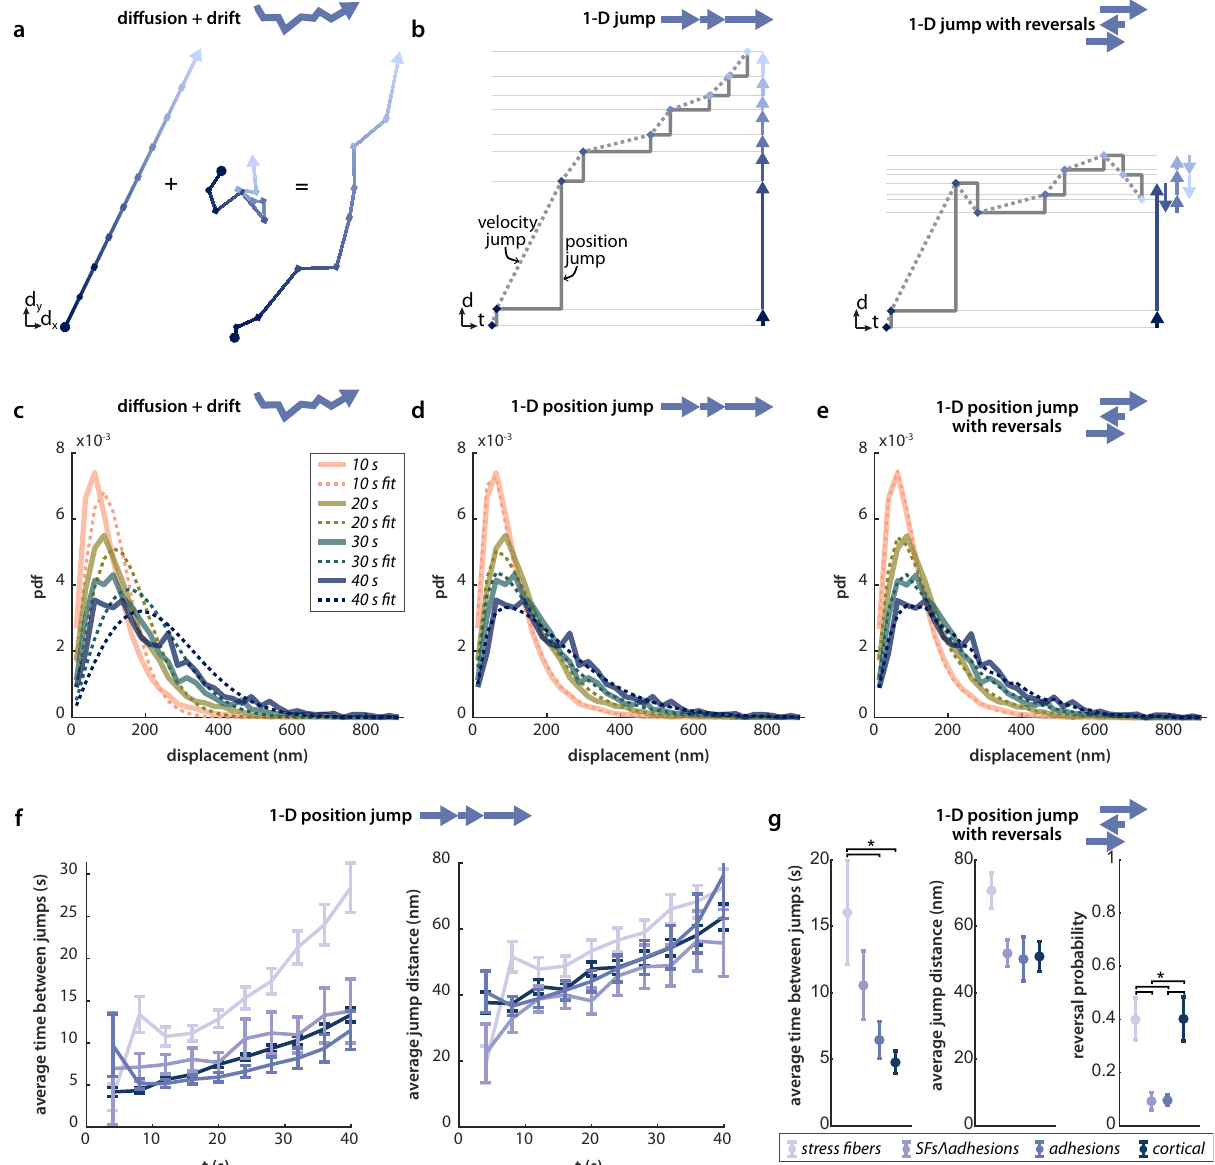
Fig. 4 F-actin velocity distributions in HFFs are well- fi t by a jump process model with exponentially distributed waiting times and jump distances. a Schematic of the diffusion with drift model. Persistent drift (left) is coupled with diffusion (center), leading to the motion shown on the right. b Schematic of the jump model, both with (right) and without (left) direction reversals. The one-dimensional motion is shown both in two-dimensional distance-time space and in one-dimensional space (arrows). The solid lines represent the motion of a position jump model, while the dashed lines represent the analogous velocity jump model. c – e The best fi ts to the stress fi ber population data by each of the models in a and b : diffusion with drift ( c ), 1-D position jump ( d ), and 1-D position jump with reversals ( e ). The fi ts are shown for four timescales and are for representative data from one experiment ( n = 9 cells). f The best fi t parameters for the 1-D jump process, for all timescales measured, averaged over four experiments. Error bars show 95% con fi dence intervals on the fi t parameters, propagated across the four datasets (see Methods, Model Fitting for details). g The best fi t parameters for the 1-D jump process with reversals, fi t to all timescales (2 – 40 s), averaged over four experiments, n = 32 total cells. Error bars show standard error of the mean of the fi t parameters from four independent datasets. Groups were compared with one-way ANOVA and asterisks denote comparisons with p -values < 0.05. P -values for comparisons between all groups are tabulated in Supplementary Table 3. Source data for c – g are provided in the Source Data fi